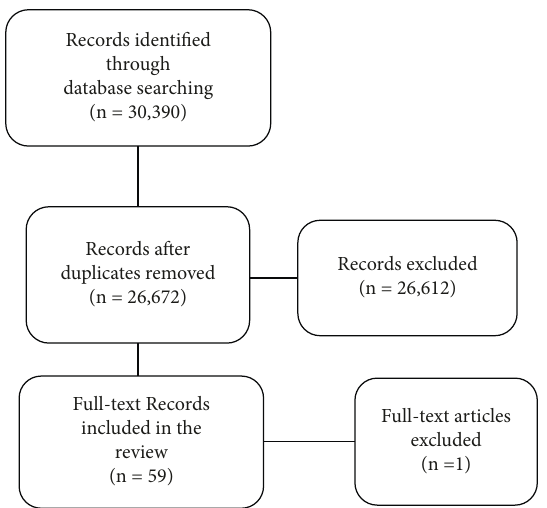
Figure 1: Study selection flow